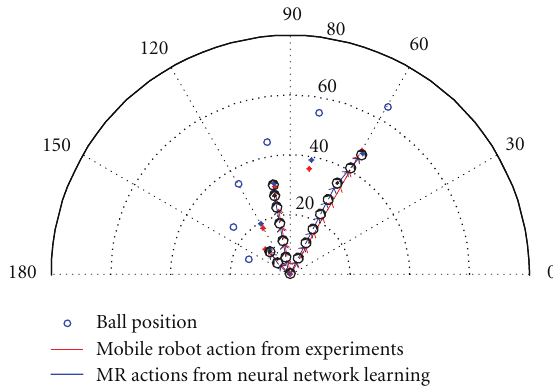
Figure 7: Experimental mobile robot with tracked target on position (65, 60), (45, 100), and (25, 140).